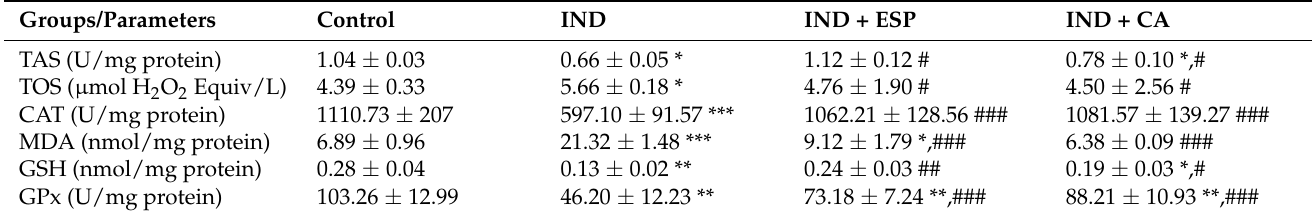
Table 4. Effects of CA on the oxidant and antioxidant parameters in gastric tissues of ulcerated rats.